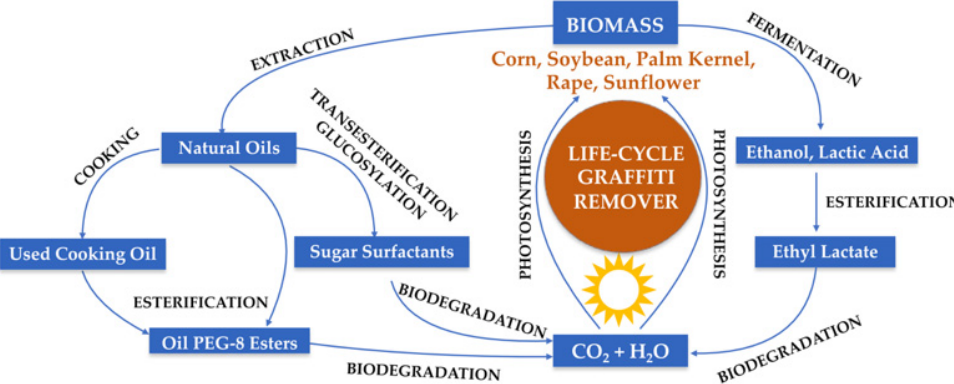
Figure 5. Lifecycle of all components of eco-friendly graffiti remover.